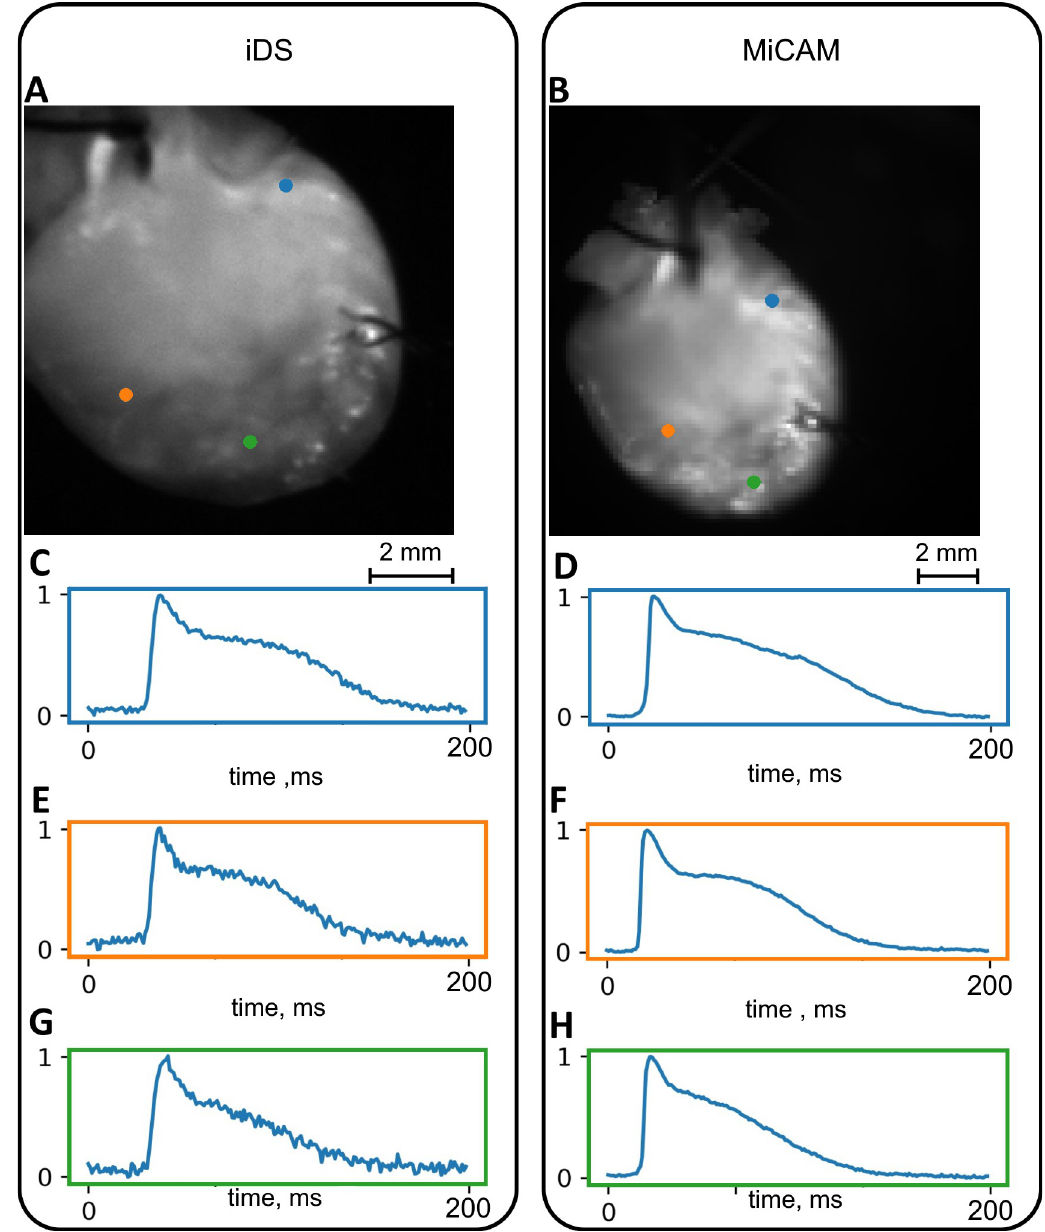
Fig 3. Conditioned signals in recordings of a mouse heart. (A),(B) Still frames with color-coded pixels corresponding to the AP waveforms. (C),(E),(G) Signals obtained from iDS camera. (D),(F),(H) Signals obtained from the MiCAM